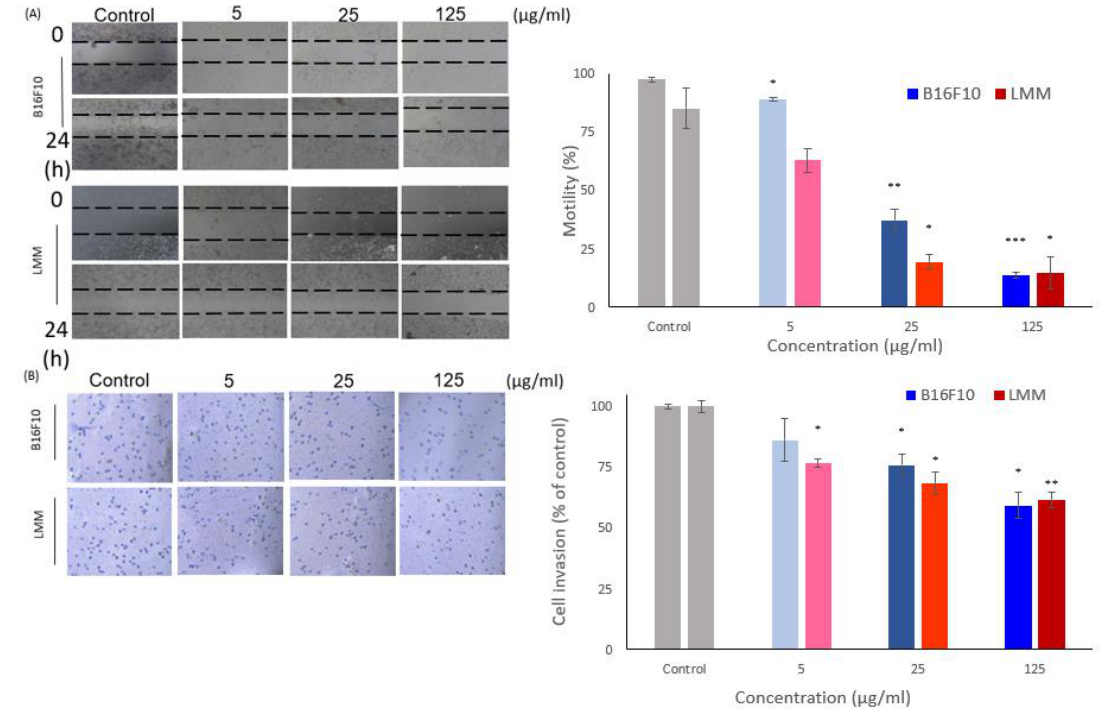
Figure 4. ( A ) The horizontal migration ability of B16F10 and LMM were tested by wound healing assay after co-incubating in different concentrations of CM. The results are shown in a microscope photo and analyzed in a histogram. ( B ) The vertical invasion ability of B16F10 and LMM was examined by Boyden invasion assay. The results are revealed in microscope photos and analyzed in a histogram. * p < 0.05, ** p < 0.01, *** p <